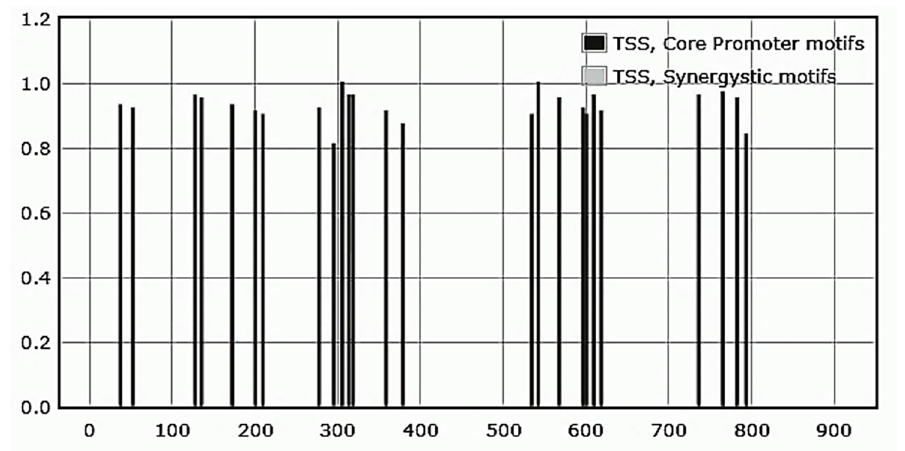
Fig 6. Profiling of the core promoter motifs identified in the upstream region of NANOGP8 DNA associated with GBM-derived exosomes. The sequences were analyzed using the YAPP Eukaryotic Core Promoter Predictor. The bars in dark grey depict individual motifs. No synergistic core promoter combination was detected. S2 Table details the sequences and the types of promoter elements.